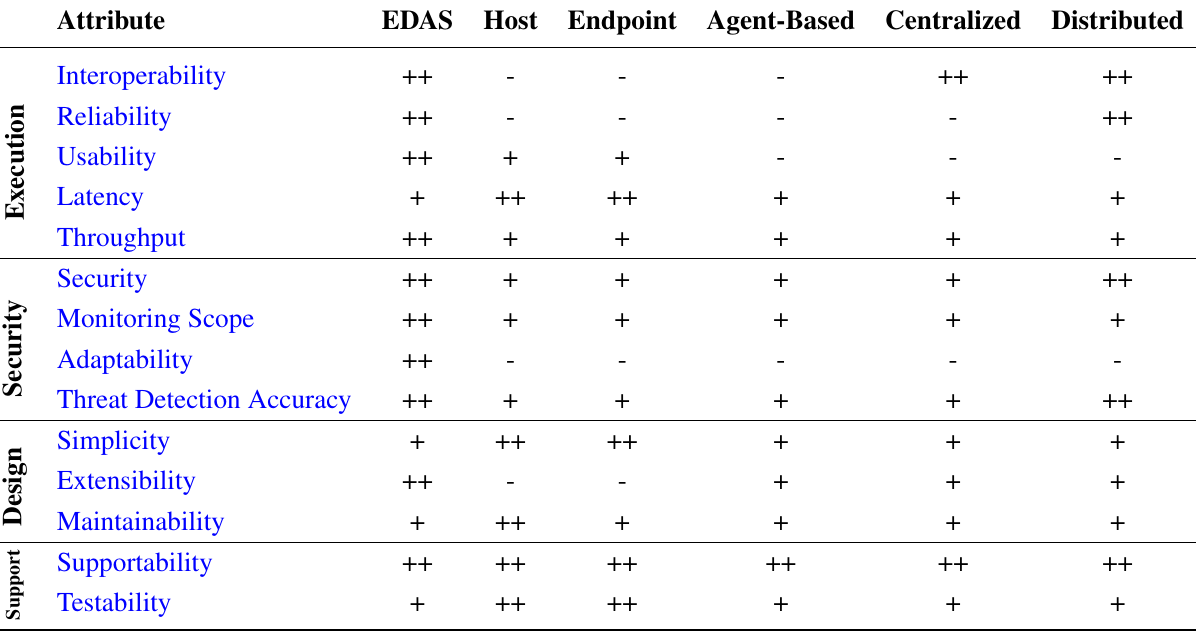
Table 4. EDAS vs. traditional security